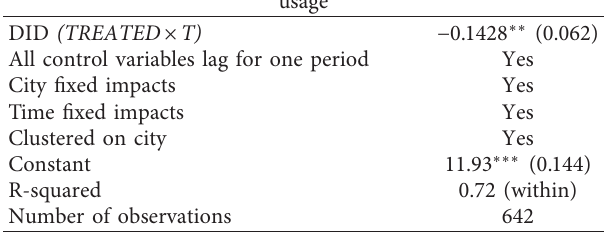
Table 10: Regression results of all control variables lagged for one